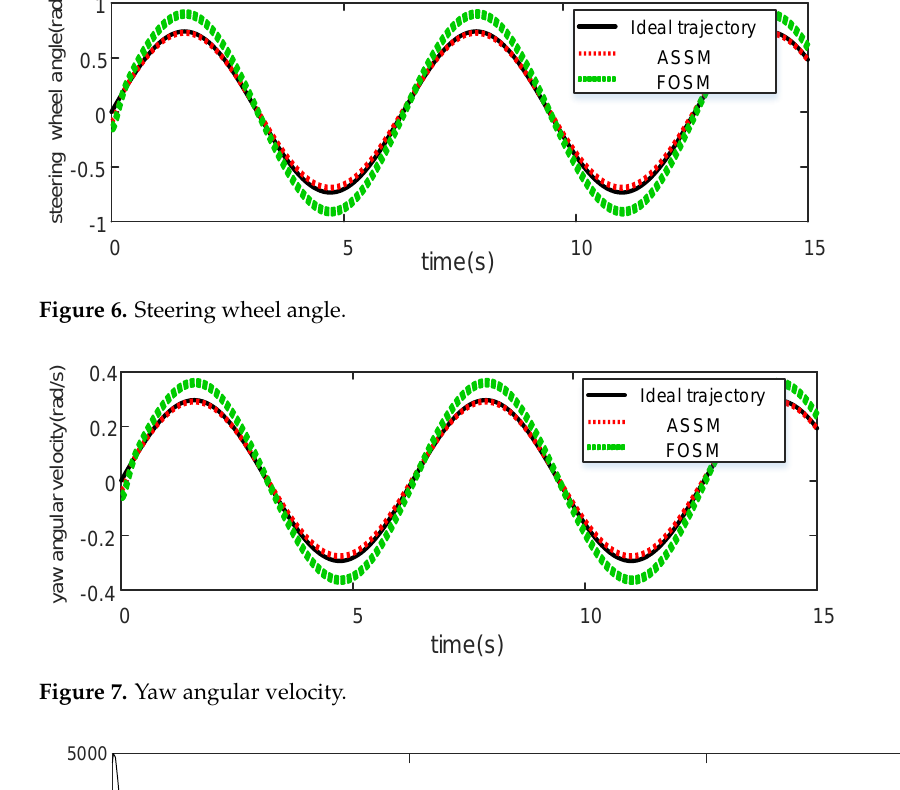
Cone Guide line Figure 5. Slalom test situation of the schematic diagram. 4.1. Slalom Condition 1: The Uniform Road Adhesion Coefficient μ = 0.85, and the Vehicle Speed is 65 km/h